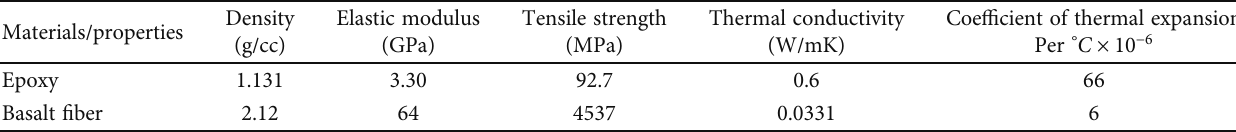
Table 1: Physical and mechanical properties of raw materials. Materials/properties